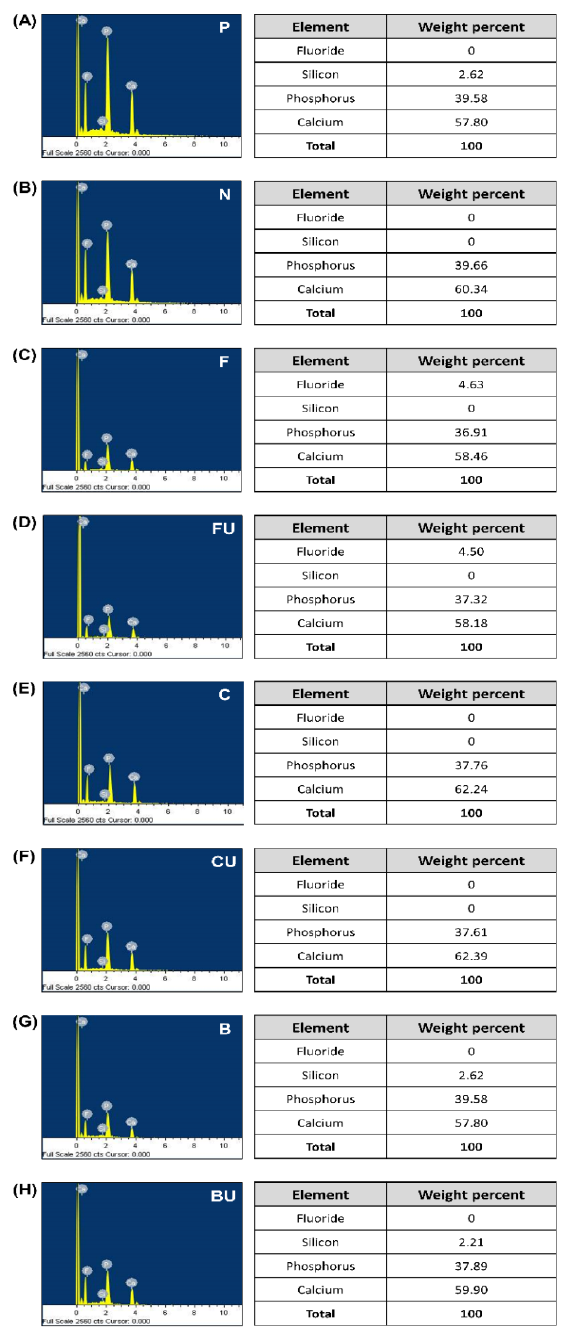
Figure 4. Results of EDS analysis. ( A ) Group P, ( B ) Group N, ( C ) Group F, ( D ) Group FU, ( E ) Group C, ( F ) Group CU, ( G ) Group B, and ( H ) Group BU. Calcium and phosphorus ions were detected in Group F and FU, and silica ion was in Group B and BU.